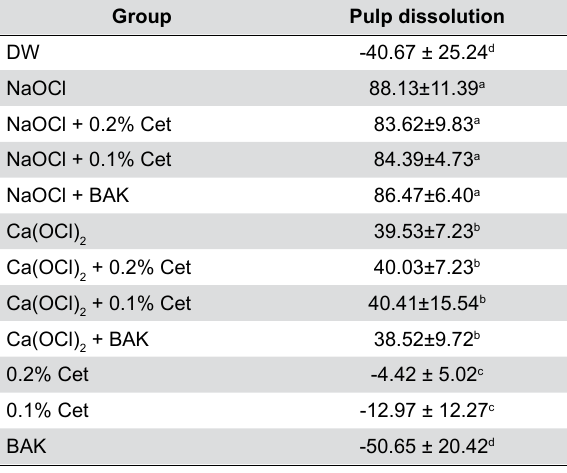
Figure 1- Representative images of solutions contact angle analysis on dentin surfaces (1) DW; (2) NaOCl; (3) Ca(OCl) cervical third; (B) apical third